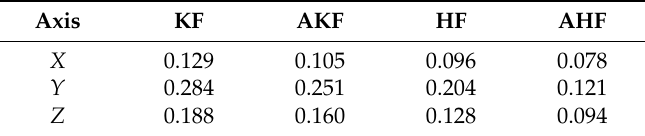
Table 2. RMSE values of the schemes (m).